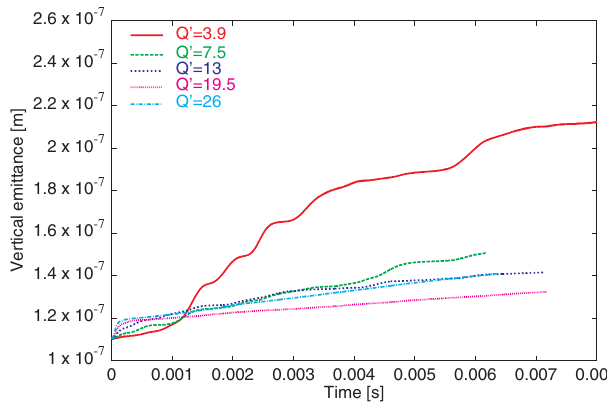
FIG. 22. (Color) Vertical emittance as a function of time for the SPS, comparing different values of vertical chromaticity Q 0 at (cid:2) (cid:2) 6 (cid:6) 10 11 m (cid:4) 3 , without space charge. A similar result was shown in Fig. 2 of